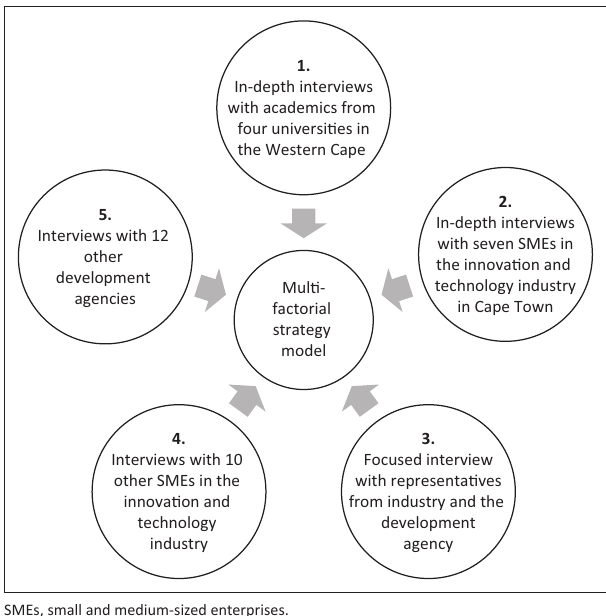
FIGURE 2: A graphical representation of the research design of this